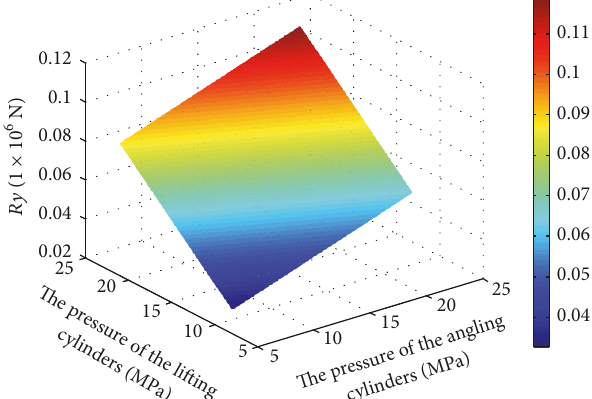
Figure 9: The component force 𝑅 𝑌 of the cutting head load perpendicular to the coal